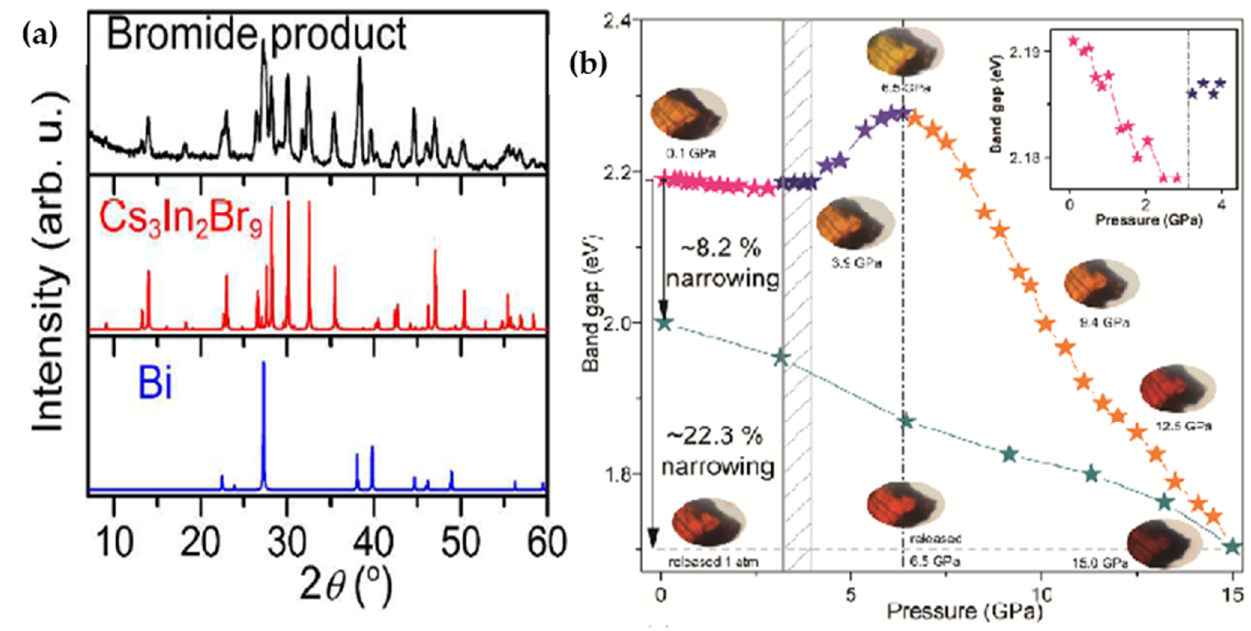
Figure 6. ( a ) PXRD pattern of the bromide product and simulated PXRD pattern for Cs 3 In 2 Br 9 and Bi. Reproduced with permission [67]. Copyright 2017,American Chemical Society; ( b ) evolution of bandgap in Cs 2 AgBrBr 6 structure at high pressure with representative optical micrographs indicating piezochromic transitions. Reproduced with permission from [56]. Copyright 2017, Wiley-VCH.